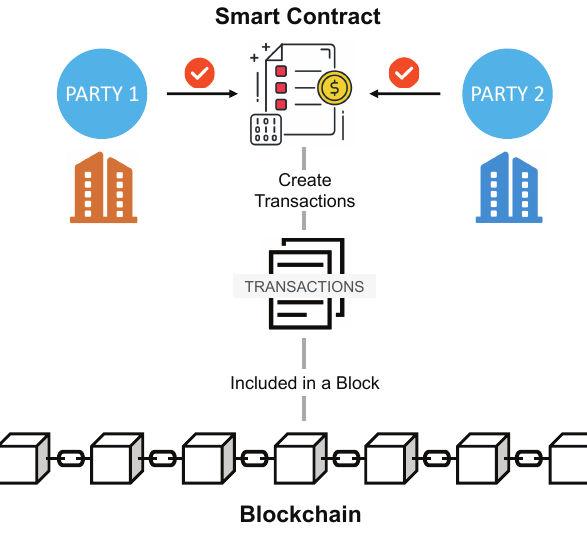
Figure 1. Blockchain-based smart